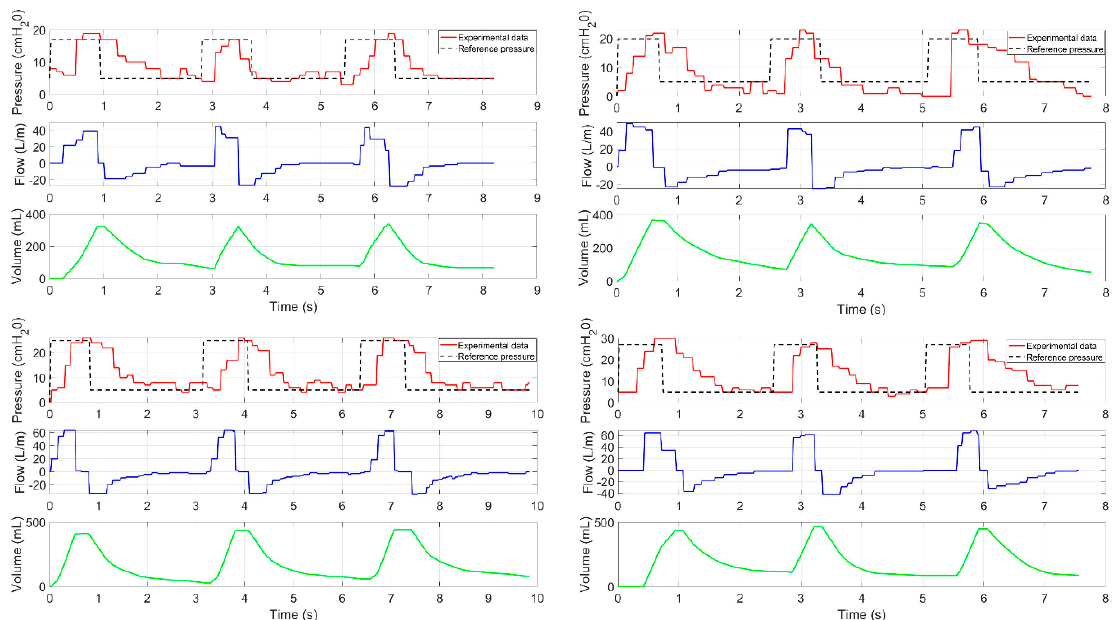
Figure 23. Experimental results from pressure control of mechanical ventilation. Top left: reference pressure 17 cm H 2 O. Top right: reference pressure 20 cm H 2 O. Bottom left: reference pressure 25 cm H 2 O. Bottom right: reference pressure 27 cm H 2 O.